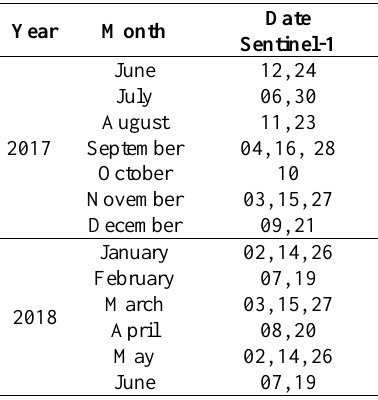
Table 2. Dates of Sentinel-1 image acquisitions over